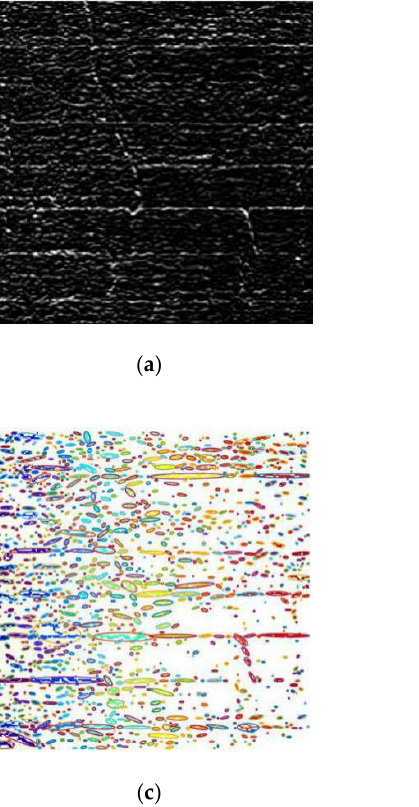
Figure 7. The contributions of oriented edge maps to the performance of the algorithm. ( a ) Horizontal edge map, ( b ) vertical edge map, ( c ) horizontal CC map and ( d ) vertical CC map.